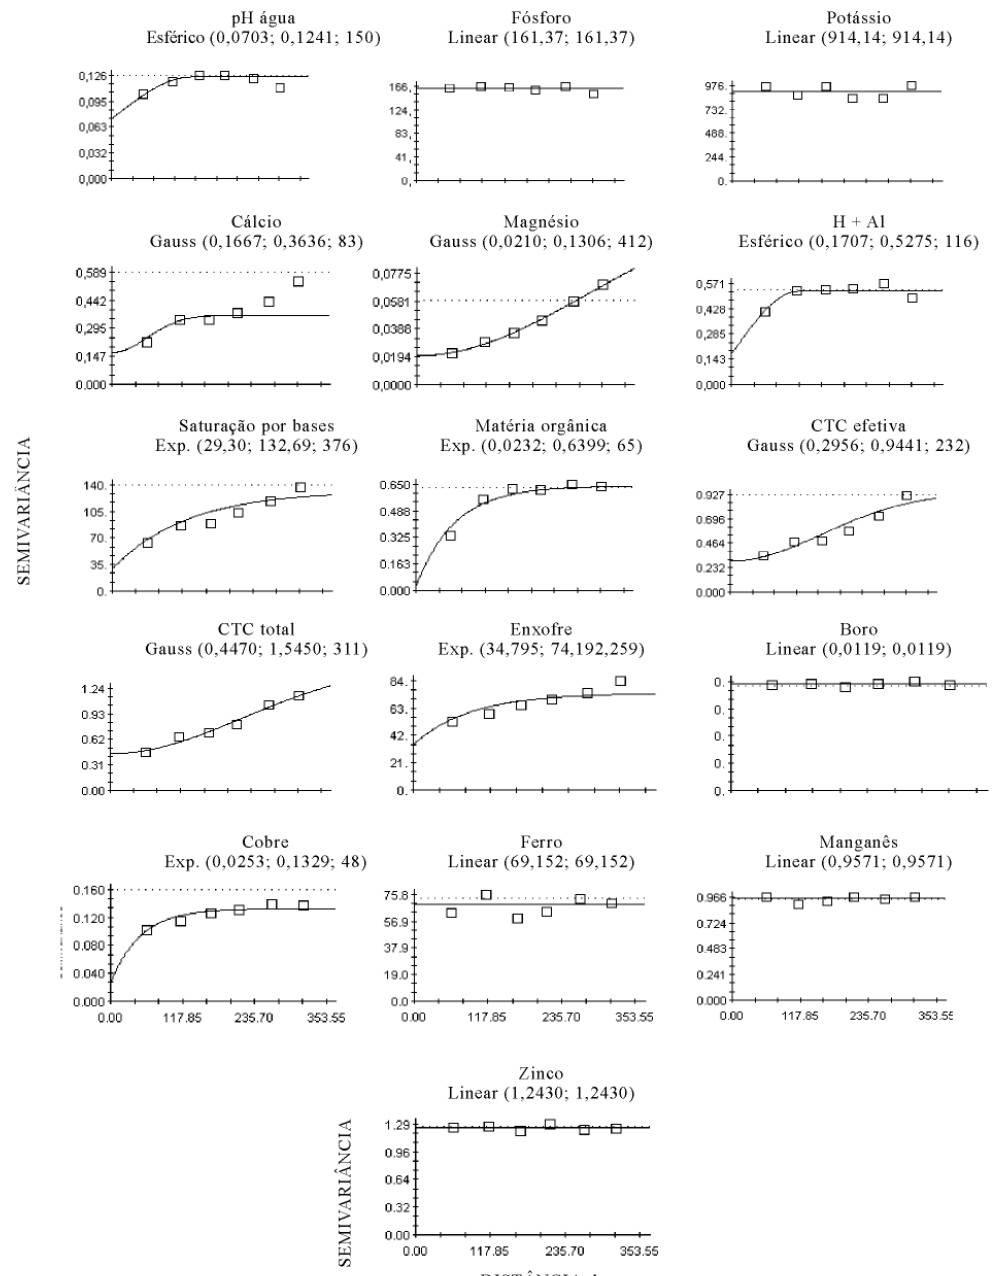
Figura 2. Semivariogramas dos atributos químicos do solo, na profundidade de 0-20 cm (valores entre parênteses são, respectivamente, efeito pepita, patamar e alcance, para todos os modelos dos semivariogramas, exceto para o modelo linear, o qual apresenta somente o efeito pepita e o